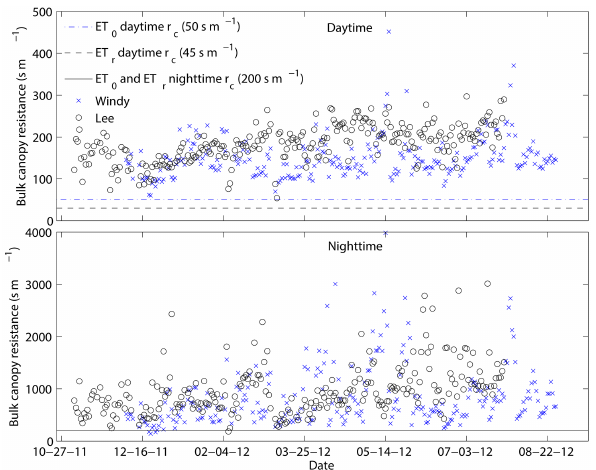
Figure 10. (a) Relationship between daily ET discrepancy (ET r - ET EC ) and daily vapor pressure deficit (VPD) from the beginning of the mid-period to the end of the study period. Regression equa- tion is fitted to the entire pool of data from Lee and Windy. (b) Re- lationship between measured ET and daily VPD; time period and regression approach are the same as in (a) .